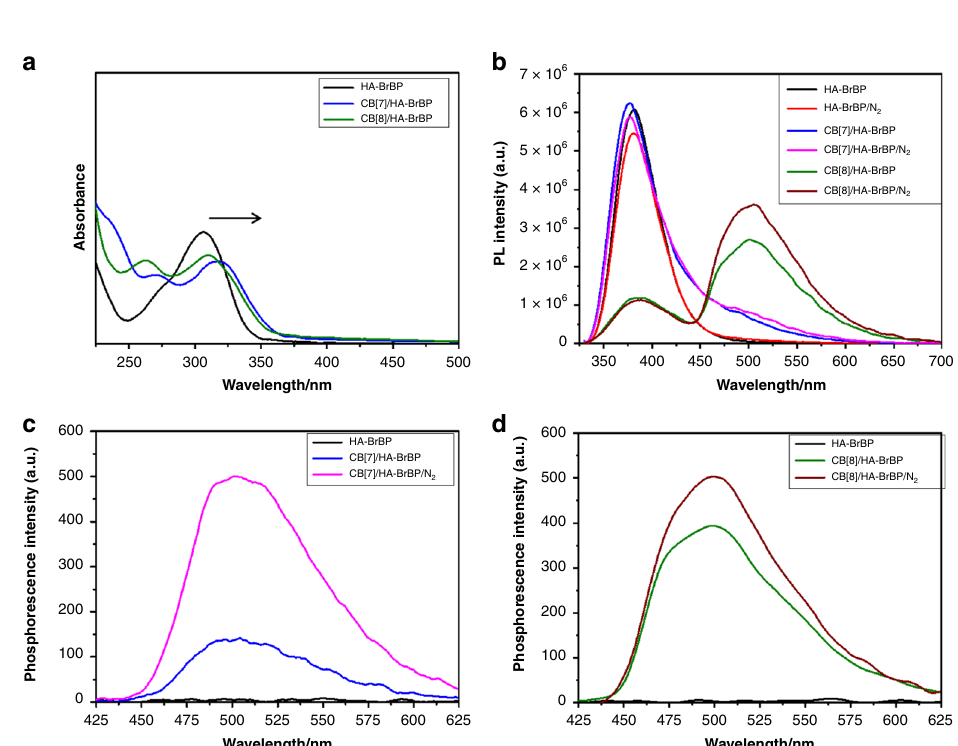
Fig. 3 Effect of complexation with CB[7] and CB[8] on the spectra of HA – BrBP. a UV – vis absorption spectra of HA – BrBP, CB[7]/HA – BrBP, and CB[8]/ HA – BrBP in aqueous solution at 25 °C ([BrBP] = 0.05 mM, [CB[7]] = 0.05 mM, [CB[8]] = 0.025mM). b The Prompt photoluminescence spectra of HA – BrBP (0.5 mM) (black), HA – BrBP/N 2 (red), CB[7]/HA – BrBP (light blue), CB[7]/HA – BrBP/N 2 (pink), CB[8]/HA – BrBP (green), and CB[8]/HA – BrBP/ N 2 (wine) in aqueous solution at 25 °C. c The phosphorescence spectra of HA – BrBP, CB[7]/HA – BrBP, and CB[7]/HA – BrBP/N 2 at 298 K in aqueous solution (delayed by 0.2 ms, Ex. Slit = 10 nm, Em. Slit = 10 nm). d The phosphorescence spectra of HA – BrBP, CB[8]/HA – BrBP, and CB[8]/HA – BrBP/N 2 at 298 K in aqueous solution (delayed by 0.2 ms, Ex. Slit = 5 nm, Em. Slit = 5 nm). ([BrBP] = 0.5 mM, [CB[7]] = 0.5 mM, [CB[8]] = 0.25